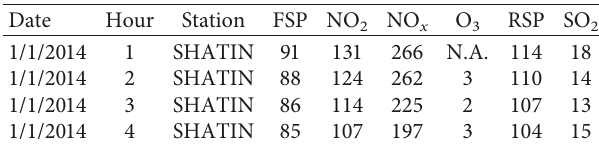
Table 2: Air pollutant